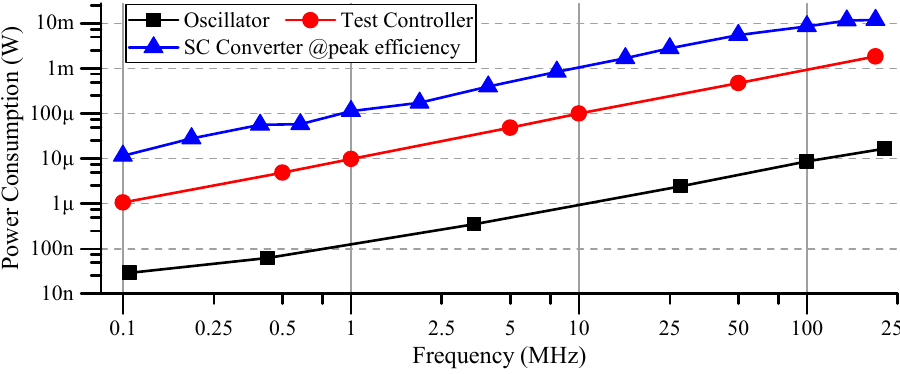
Figure 12. Measurement result for transitions between sleep and the active period of the load.